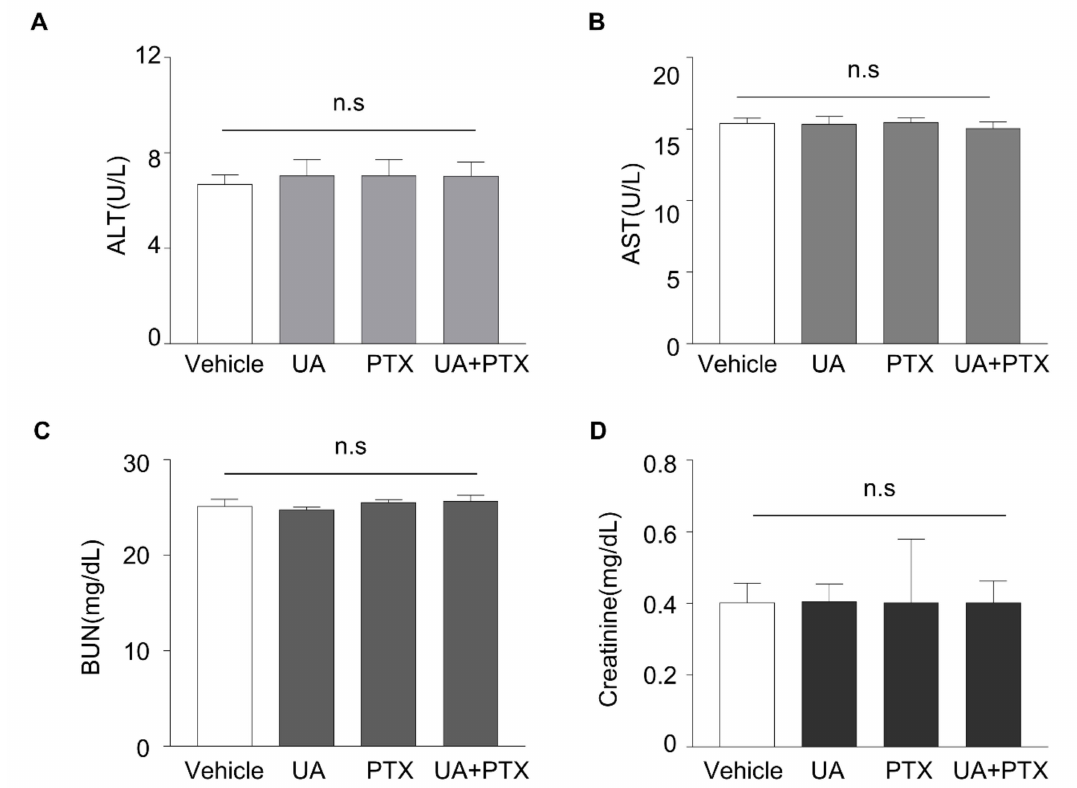
Figure 7. Toxic effect of UA and PTX in xenograft animal model. Xenograft model was performed with the TE-8 cell line. After tumors were established, the mice were injected with DPBS, UA, PTX, or UA plus PTX for three weeks. The serum biochemical indexes for ALT ( A ), AST ( B ), BUN ( C ), and creatinine ( D ) were used for the drug safety evaluation. n.s, not significant; Vehicle, DPBS; UA, ursolic acid 30 µ M; PTX, paclitaxel 25 nM; UA+PTX, combination treatment of ursolic acid 30 µ M and paclitaxel 25